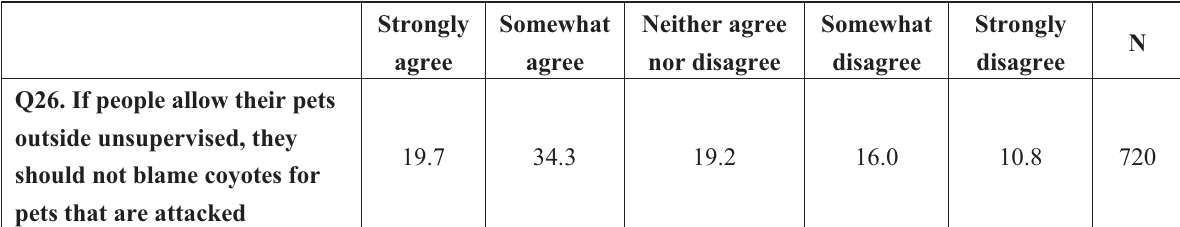
Table 13. Level of agreement with whether coyotes should be blamed for predations of unsupervised pets. Given in